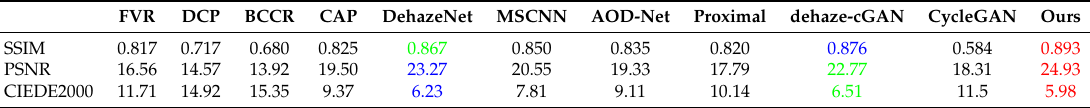
Figure 10. Examples of paired data generated by our network. ( a – d ) Clean images. ( e – h ) Generated hazy images corresponding to ( a – d ). Table 3. Average PSNR, SSIM, and CIEDE2000 values of dehazed results on the new synthetic dataset. The best result, the second result, and the third place result are represented by red, blue, and green, respectively. The average values of PSNR , SSIM and CIEDE2000 results calculated directly between the each hazy and its corresponding clean image.